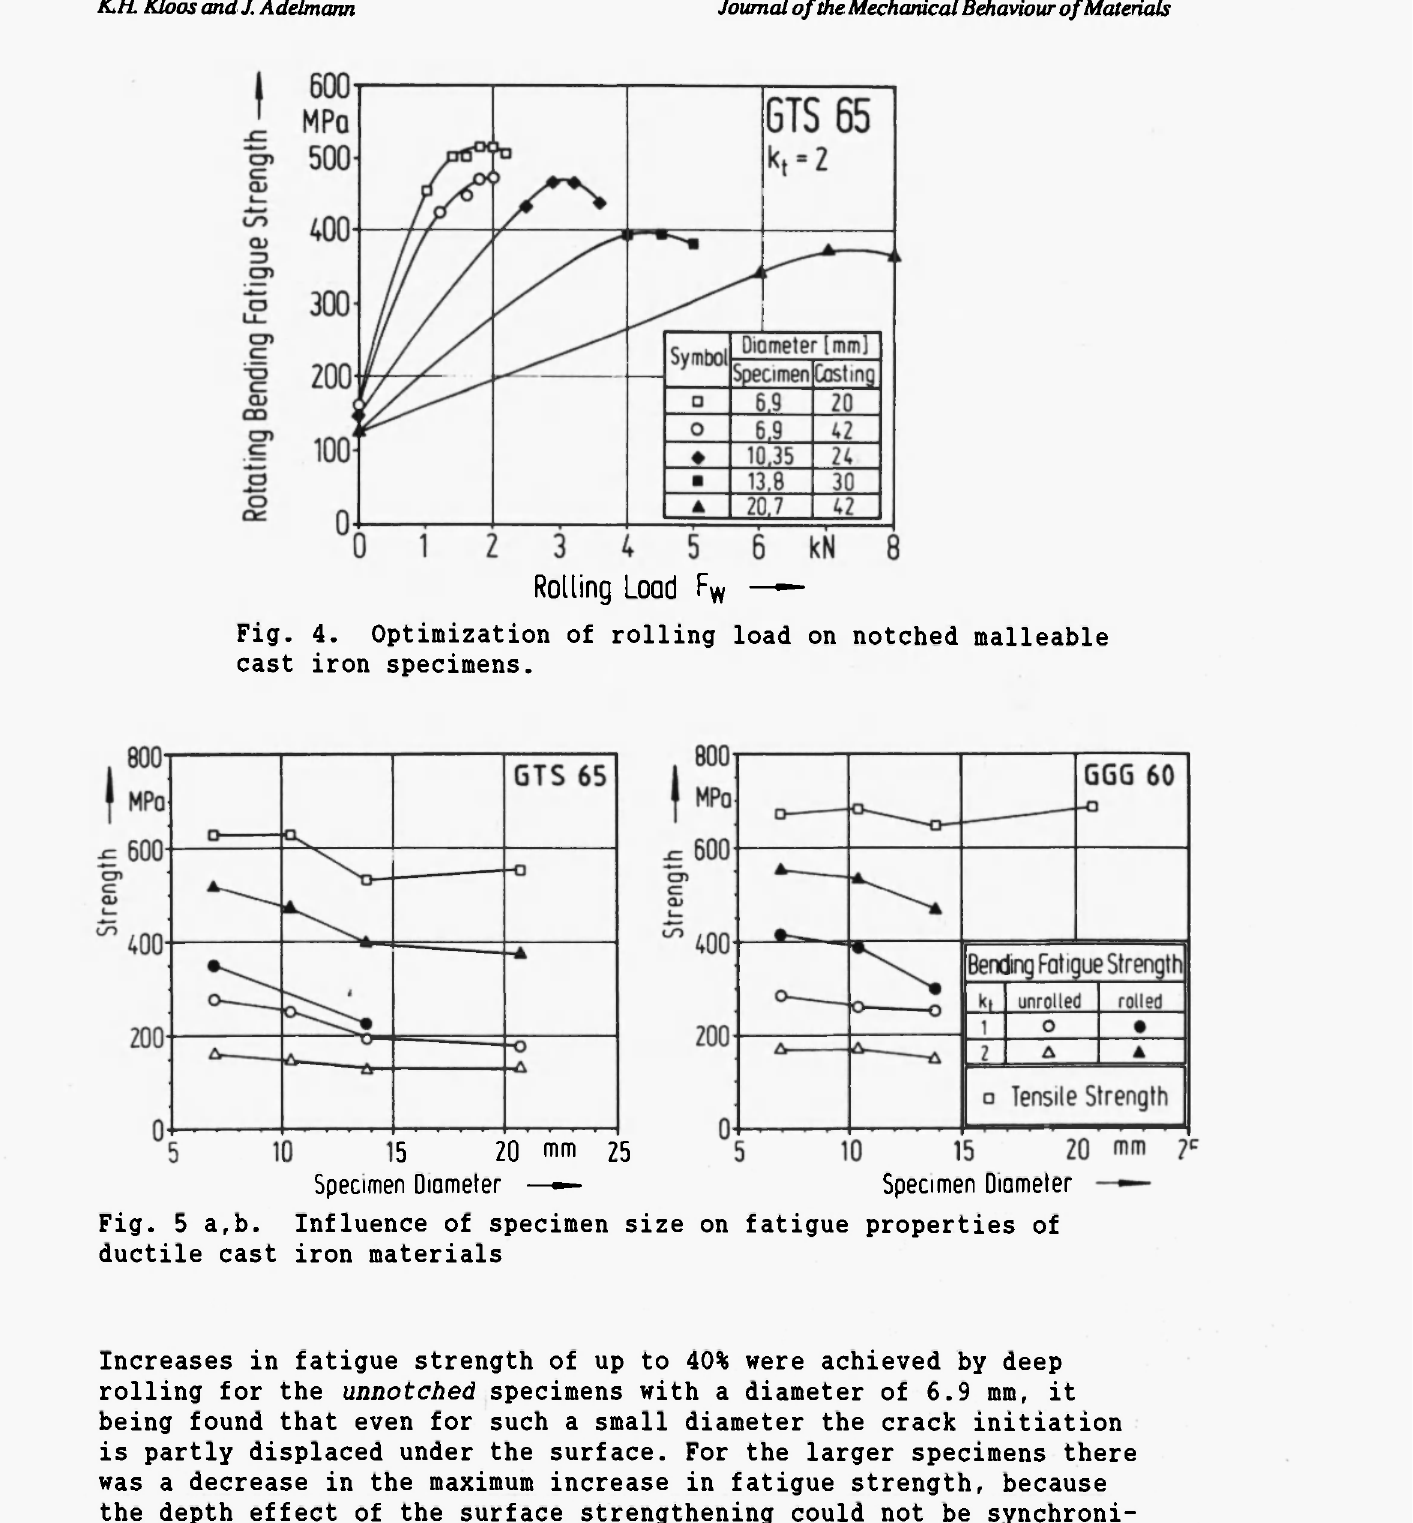
Fig. 5 a,b. Influence of specimen size on fatigue properties of ductile cast iron materials